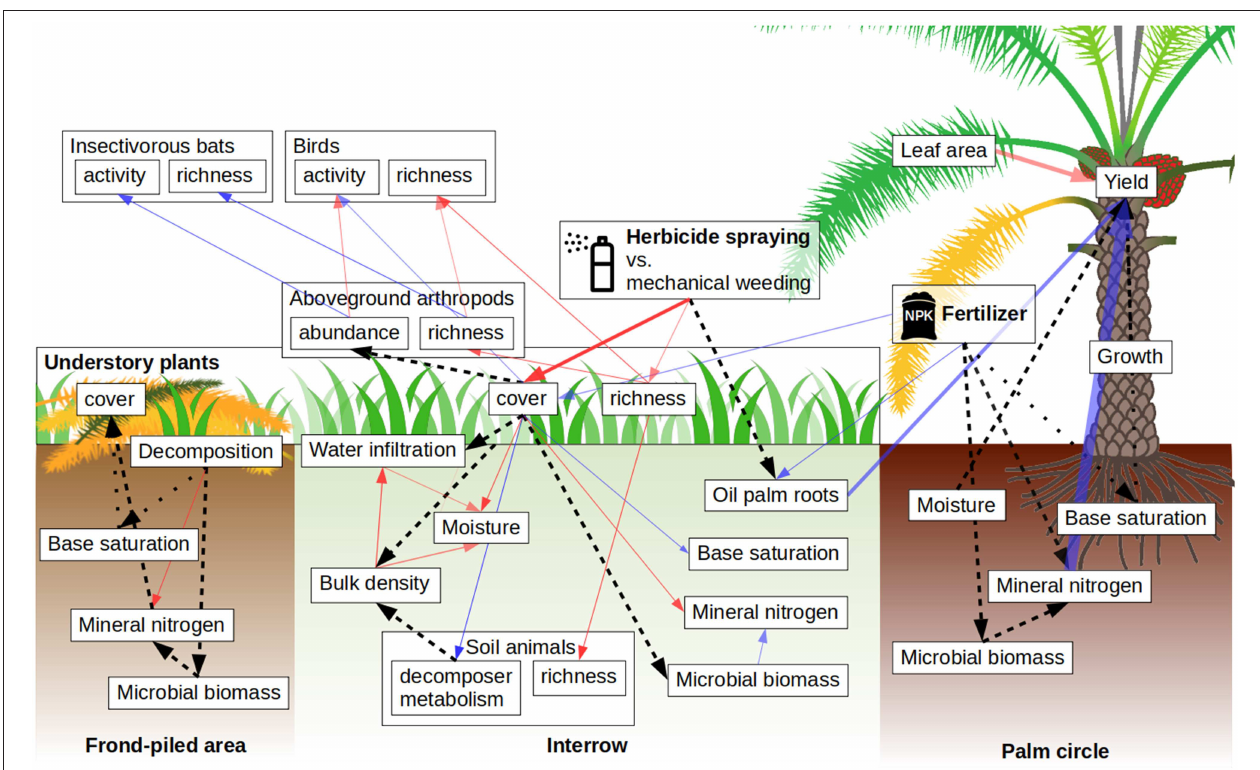
FIGURE 4 | Bayesian structural equation modeling results. All hypothesized paths are indicated with arrows. Full arrows correspond to paths that are three times more likely than their opposite paths: Red arrows indicate negative effects, blue arrows indicate positive effects. Black dashed arrows indicate tested, inconclusive links. Black dotted arrows are hypothesized links that could not be tested with our model due to insufficient variability (base cations were saturated in palm circles and the frond-piled area). Arrow opacity scales with the probability, and arrow width scales with the logarithm of the effect